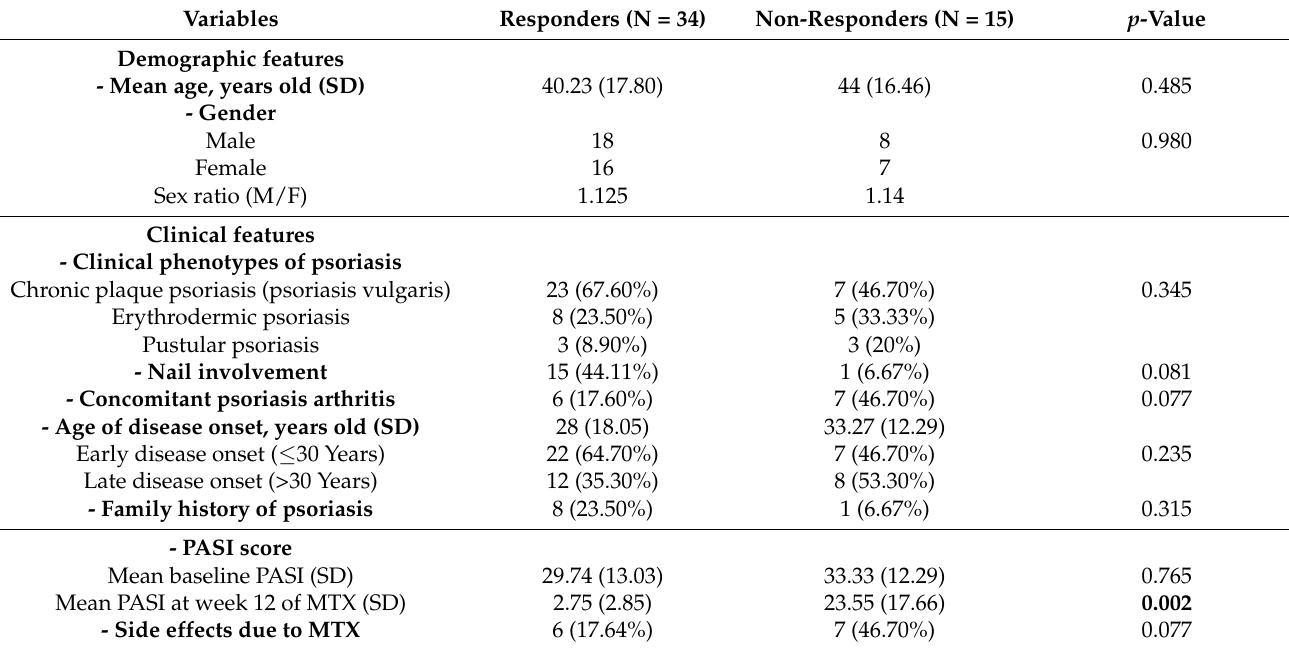
Table 2. Demographic and clinical characteristics in responders and non-responders to